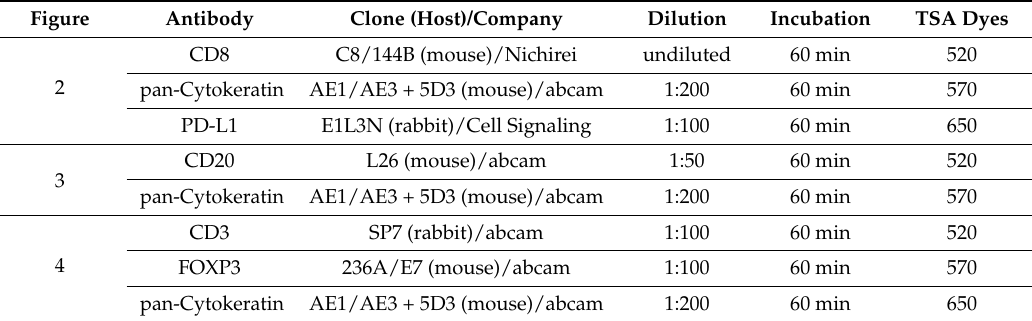
Table 1. The list of antibodies used for fluorescent multiplex immunohistochemistry analysis. Figure Antibody Clone (Host)/Company Dilution